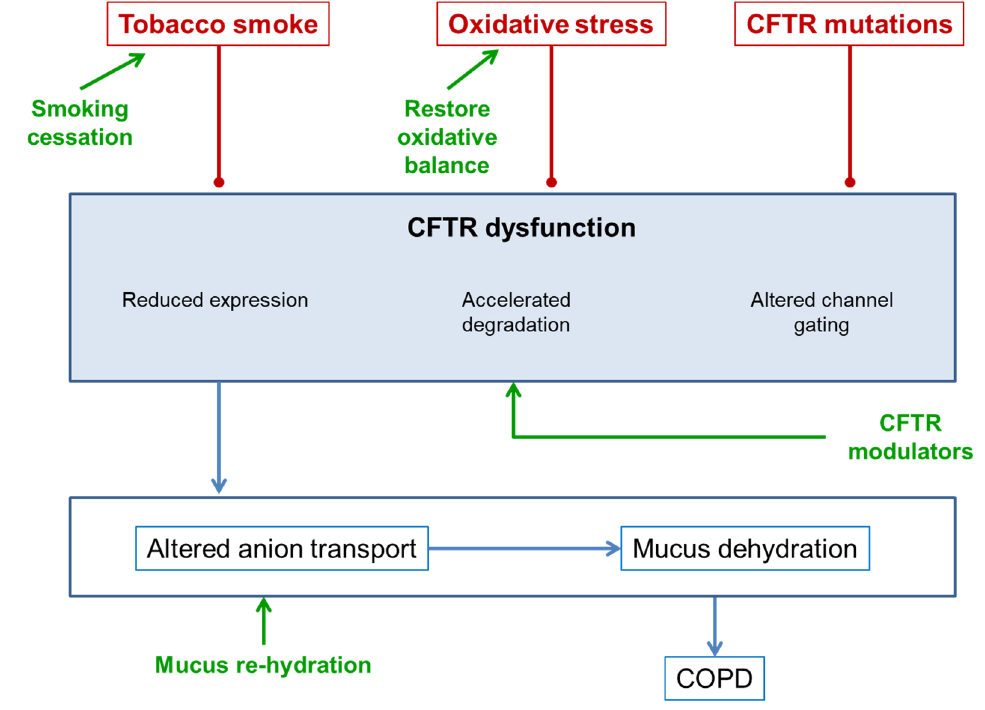
Figure 3. Therapeutic points of action of CFTR dysfunction.